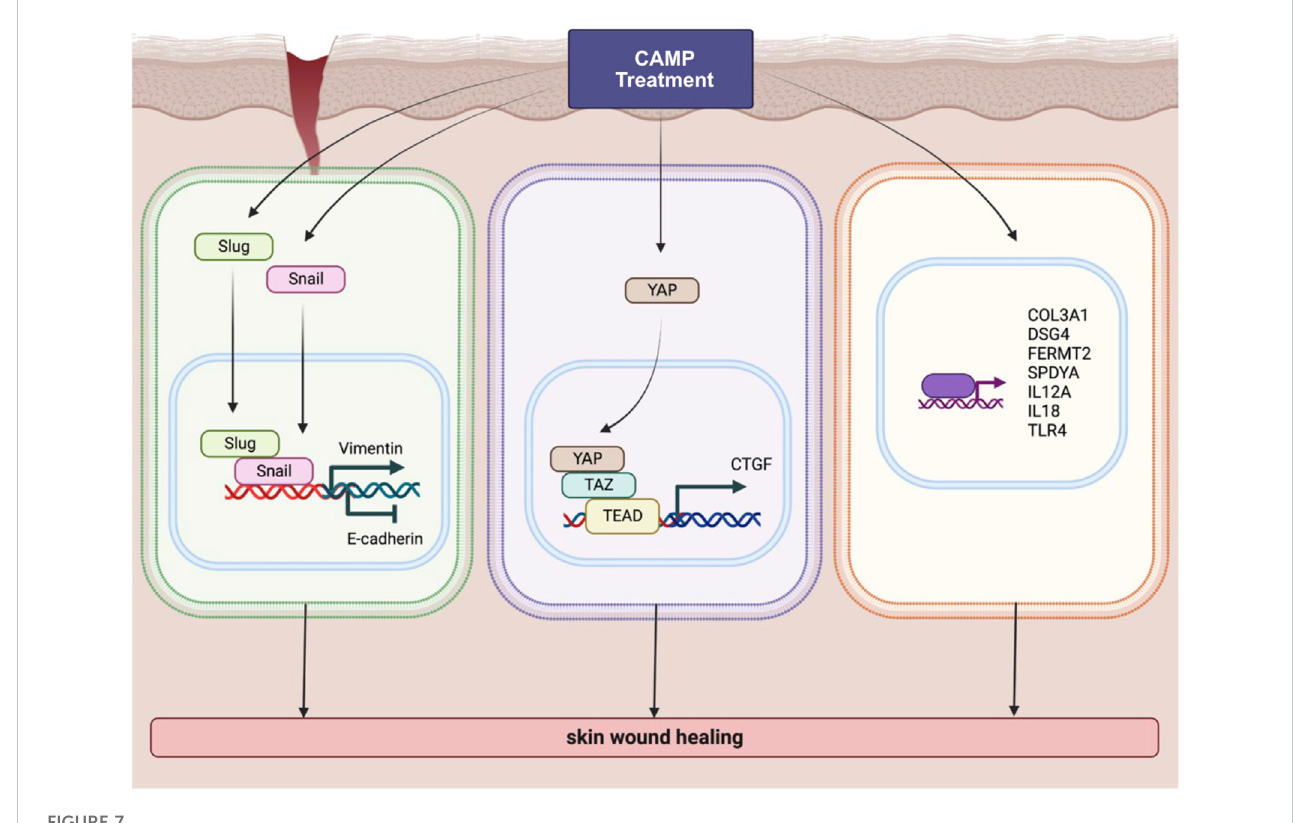
FIGURE 7 Schematic diagram represents various pathways involved in wound-healing activity induced by CAMP treatment.